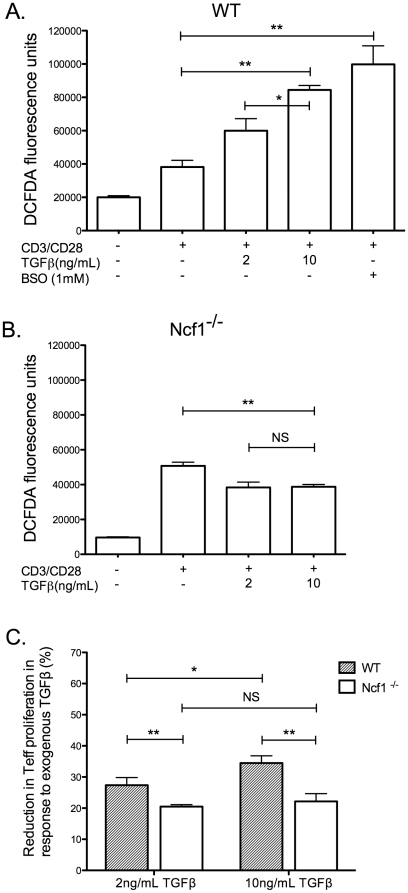
Treatment of Teffs with TGFβ results in a dose dependent elevation of intracellular oxidants.(A) Isolated, unlabeled Teffs, without Tregs, were cultured in the indicated conditions with exogenous TGFβ (2 and 10 ng/mL) or with the gamma-glutamylcysteine synthetase inhibitor buthionine sulfoximine (BSO; 1 mM) to deplete intracellular glutathione, and anti-CD3/CD28 beads for 24 hours. Subsequently, samples were labeled with the fluorescent, oxidant sensitive cell permeable indicator dye 5-(and-6)-chloromethyl-2′,7′-dichlorodihydrofluorescein diacetate, acetyl ester (DCFDA), each for exactly 15 minutes then immediately subjected to flow cytometric evaluation of DCFDA fluorescence. The data shown represents mean fluorescence intensity of DCFDA and is representative of three identical experiments, each performed in triplicate and each yielding similar results. (B) A similar experiment was performed using Teffs isolated from Ncf1-deficient mice. (C) CFSE labeled WT or Ncf1-deficient Teffs were stimulated as indicated for four days with anti-CD3/CD28 beads with and without exogenous TGFβ (2 and 10 ng/mL) then evaluated for proliferation by flow cytometric quantification of CFSE staining. The data shown represents the % reduction in proliferation of TGFβ treated Teffs vs untreated Teff samples and is representative of three identical experiments (NS – not significant, * p<0.05, **p≤0.01).